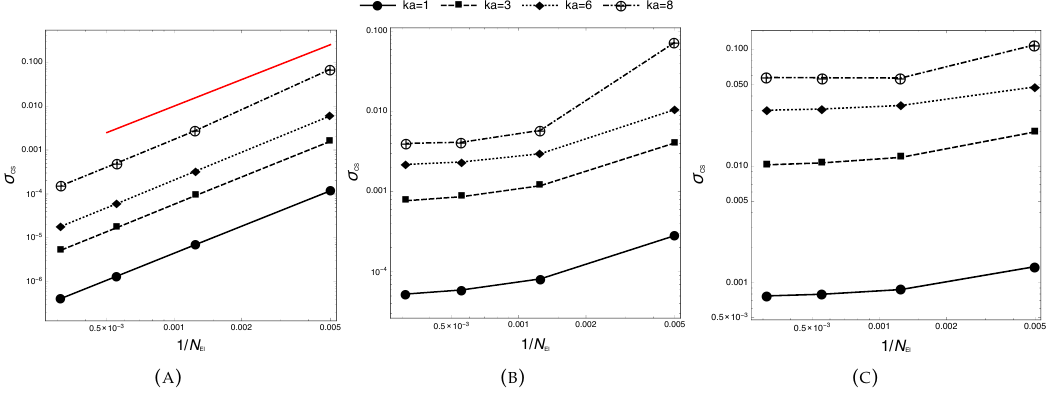
Figure 4. Convergence of σ cs with the number of field elements in Ω c , N el , for four values of ka . Equation (3). Mach number M b = 0.0,0.1,0.2 ( A , B , and C , respectively). The red line indicates the h 2